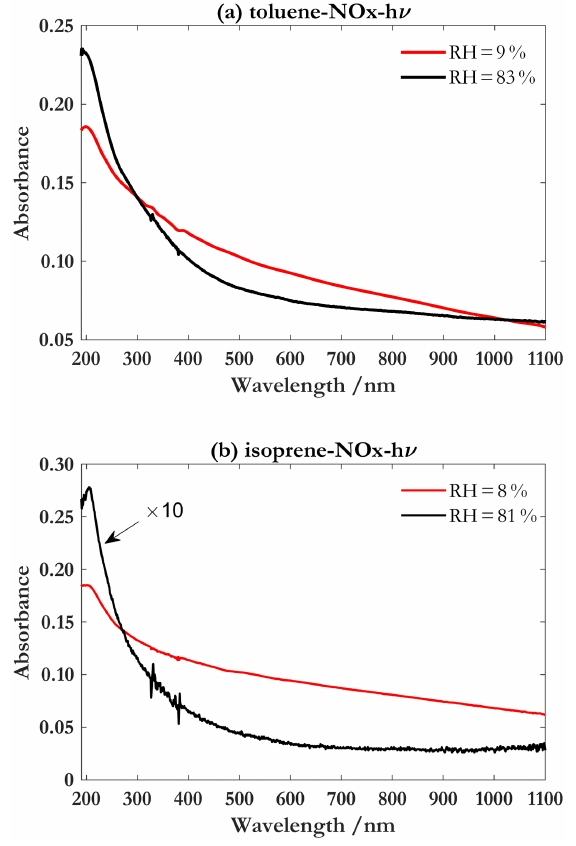
Figure 4. UV-Vis spectra of SOA from toluene (a) and isoprene (b) photooxidations under dry and humid conditions.